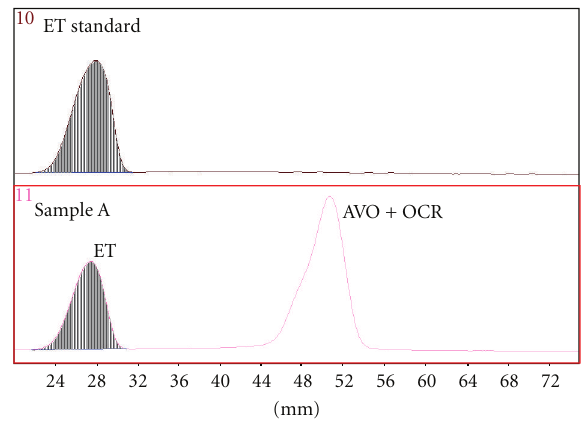
Figure 2: Densitograms of Sample A and ET standard (300nm), Method A.